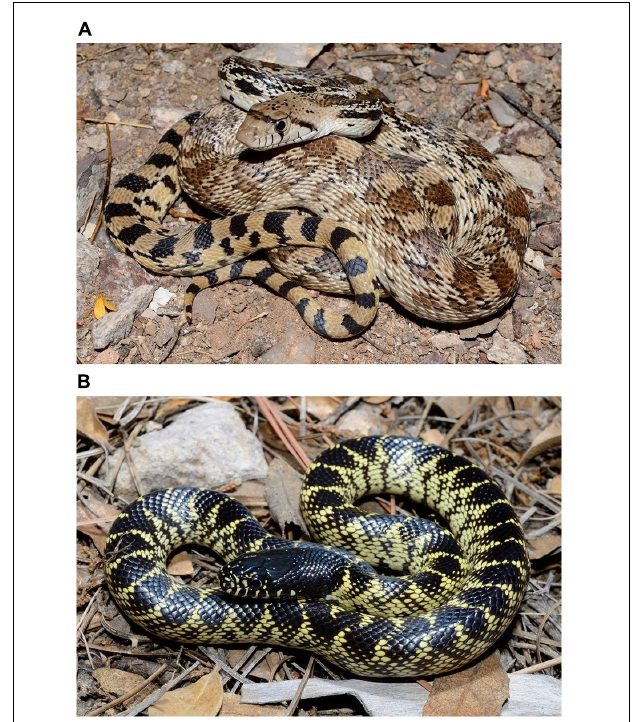
FIGURE 2 | (A) Sonoran Gophersnake ( Pituophis catenifer ). Vulture Mine Road, Maricopa County, Arizona. (B) Desert Kingsnake (